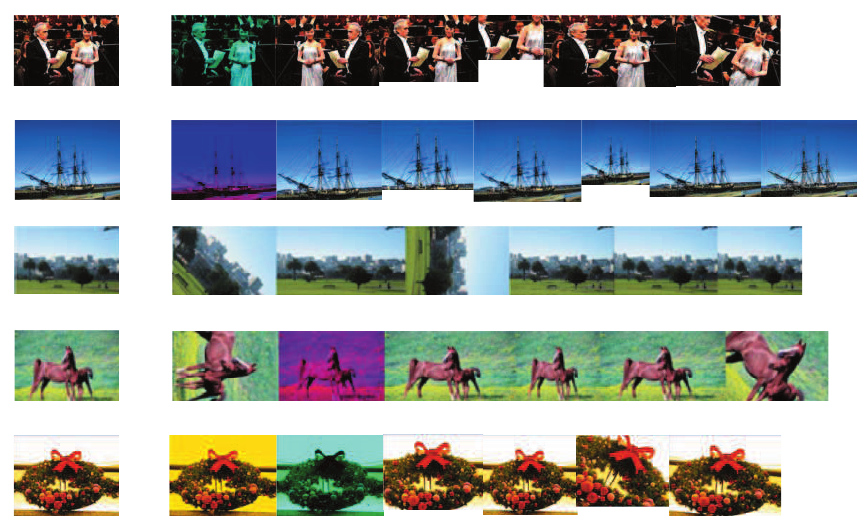
Figure 2: Sample images and corresponding sample image